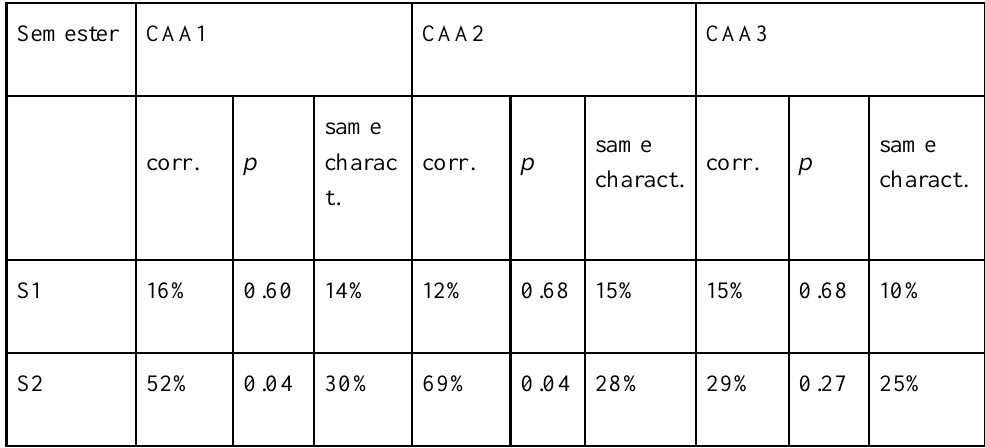
Correlation Results (corr.) and Statistical Significance (p) between Automatic and Human Evaluation, and Percentage of CAAs Satisfying the Same Characteristics as the Reference Solutions (same